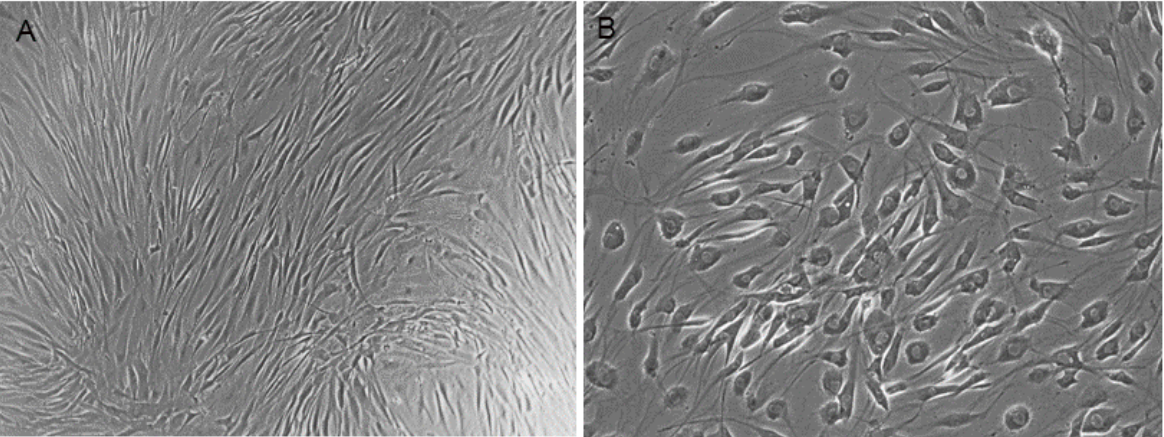
FIGURE 2. Morphology of undifferentiated hASCs (A) and when cultured in hepatic induction medium (B). Undifferentiated hASCs display a fibroblast-like shape, while during hepatic differentiation, they acquire a polygonal or round shape. Phase contrast magnification 